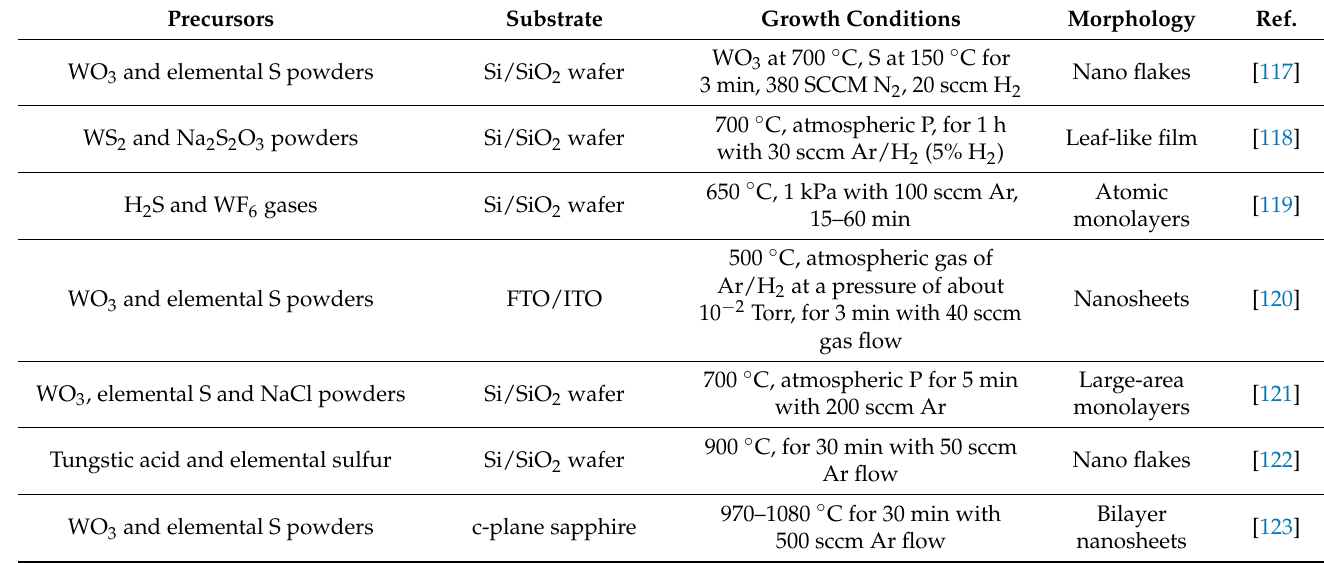
Table 3. Examples of CVD-grown WS 2